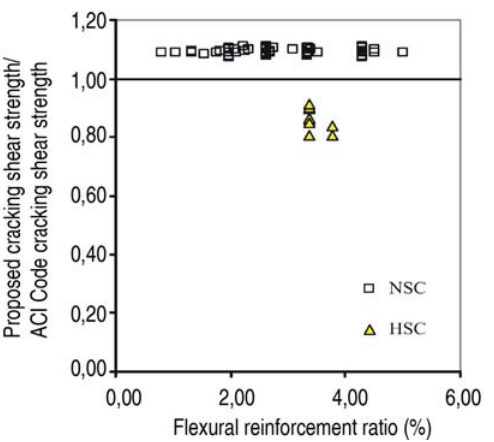
Fig. 4. Comparing proposed cracking shear strength of Eq (15) with ACI Code for various flexural reinforcement